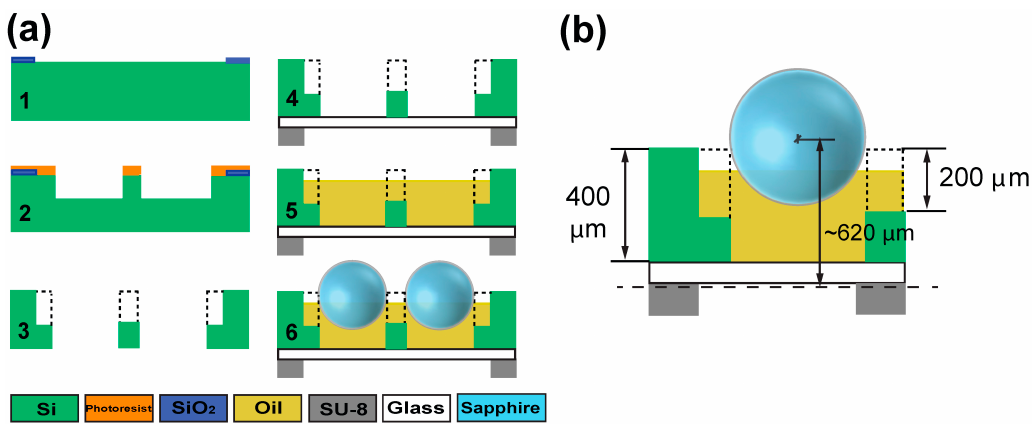
Figure 2. ( a ) Microfabrication process and ( b ) Critical dimensions of the µOIL chip. The focal length measured from the center of the ball mini-lens is ~620 µm. The dotted lines represent the microwell sidewalls that are not visible in the highlighted cross